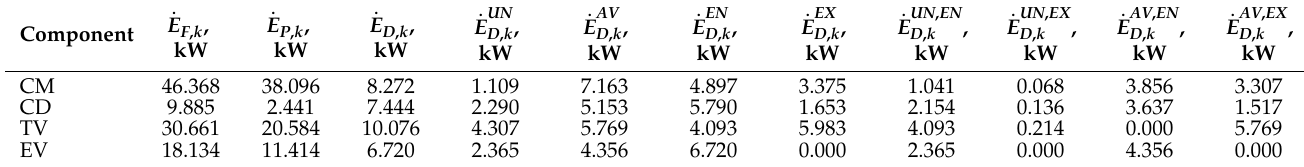
Table 7. Results obtained from the advanced exergy analysis based on the authors’ model.